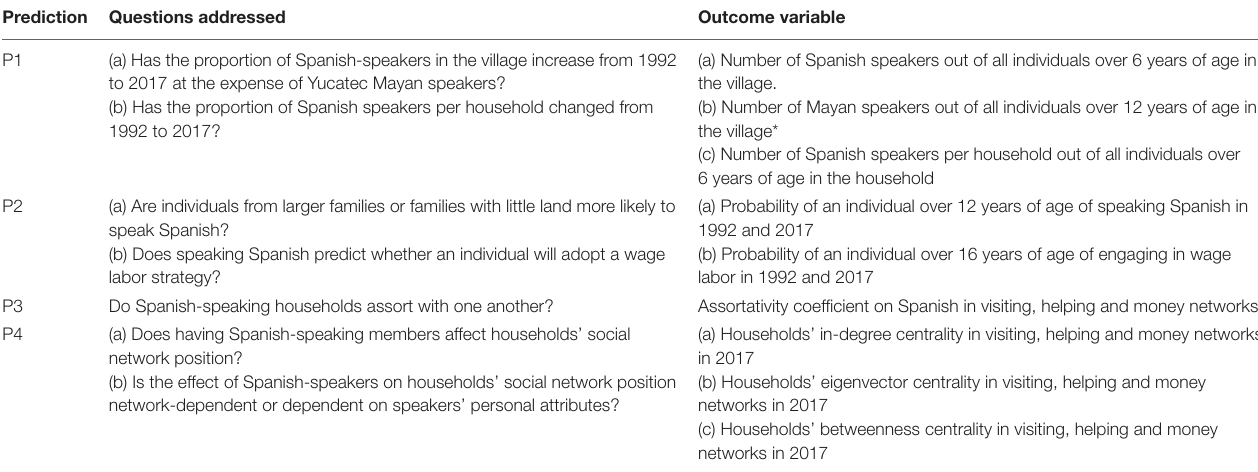
TABLE 1 | Summary of the empirical questions addressed with each prediction and the outcome variable used to test